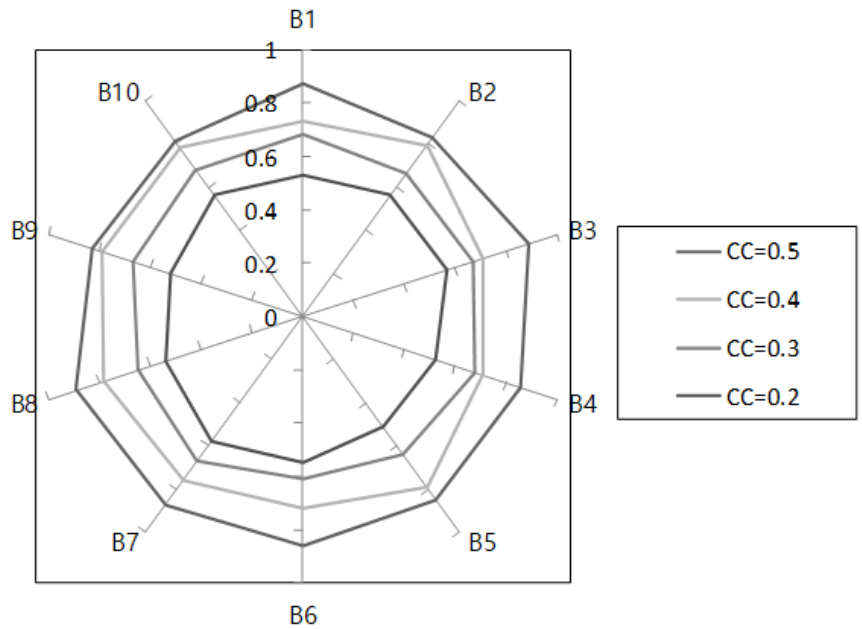
Figure 5. Average congestion control ratio with CC and FV.